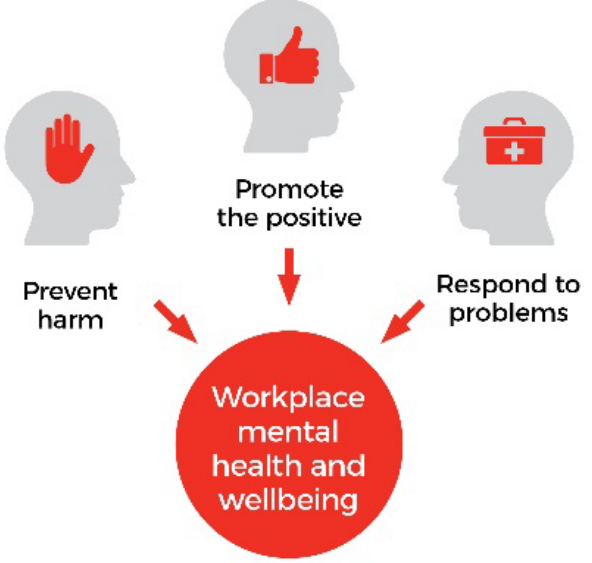
Figure 1. An integrated approach to workplace mental health.